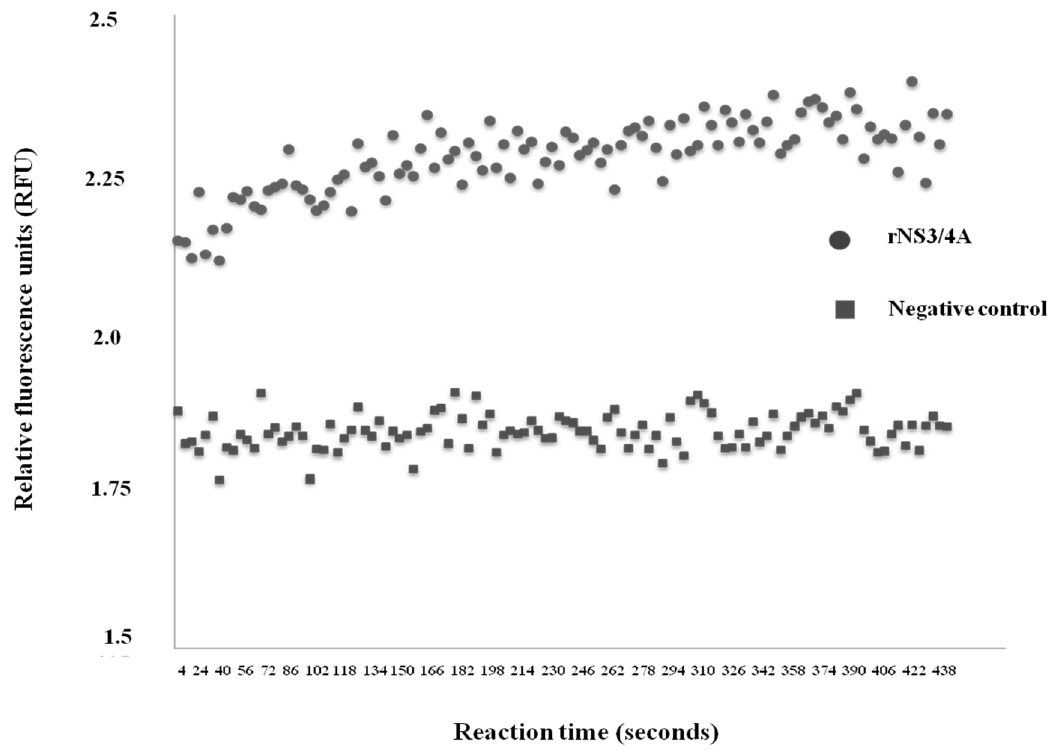
Figure 1. Protease activity of the recombinant rNS3/4A protein as determined by fluorescence resonance energy transfer (FRET) assay. The rNS3/4A cleaved the fluorogenic substrate, DE-D(EDANS)-EE-Abu- ψ -[COO]-AS-K-( DABCYL), and released the